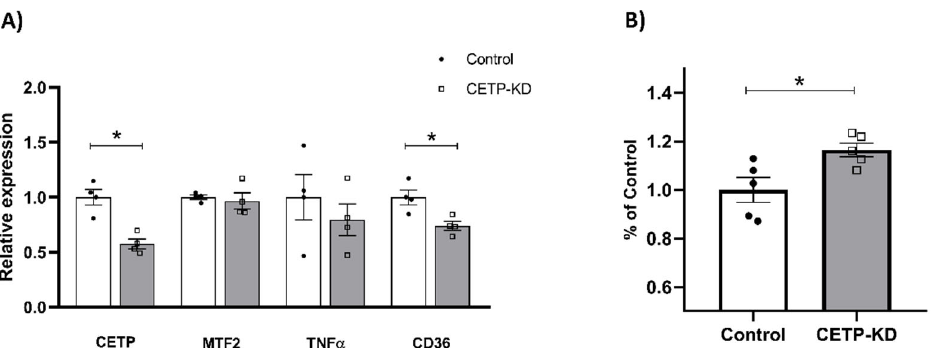
Figure 8. Knockdown of CETP in THP1 cells increased unesterified cholesterol content and did not affect mitofusin-2 and TNF α gene expression. THP1 human cells treated with siRNA targeted to CETP or control siRNA were evaluated for mRNA levels of key genes ( A ) and stained for membrane cholesterol with filipin ( B ). * p < 0.05.